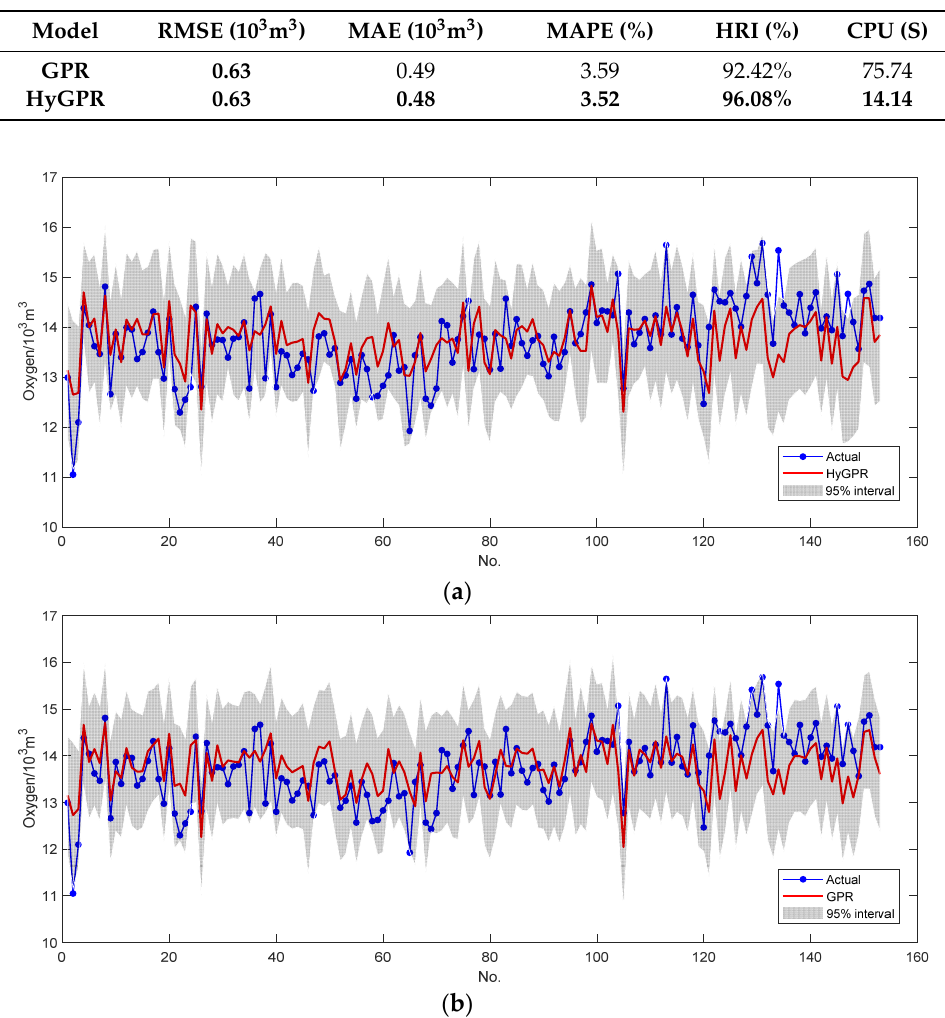
Figure 6. Interval forecasting results of oxygen consumption: ( a ) HyGPR; ( b ) standard GPR. Table 4. Accuracy and interval metrics of GPR and HyGPR (The best metrics are highlighted in bold).